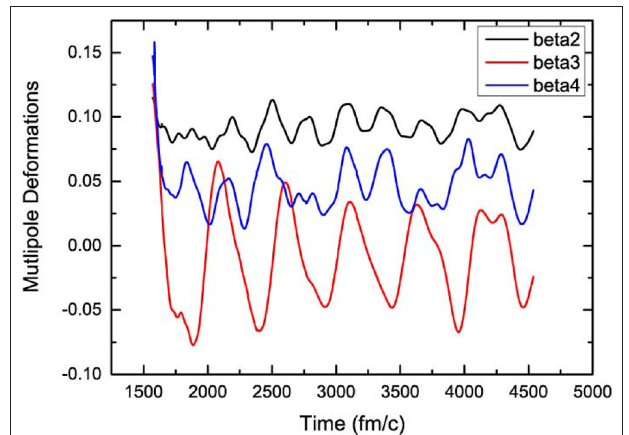
FIGURE 3 | The evolutions of quadrupole deformations in TDHF calculations with the SV-sym28, SV-bas, SV-sym30, SV-sym34 forces.